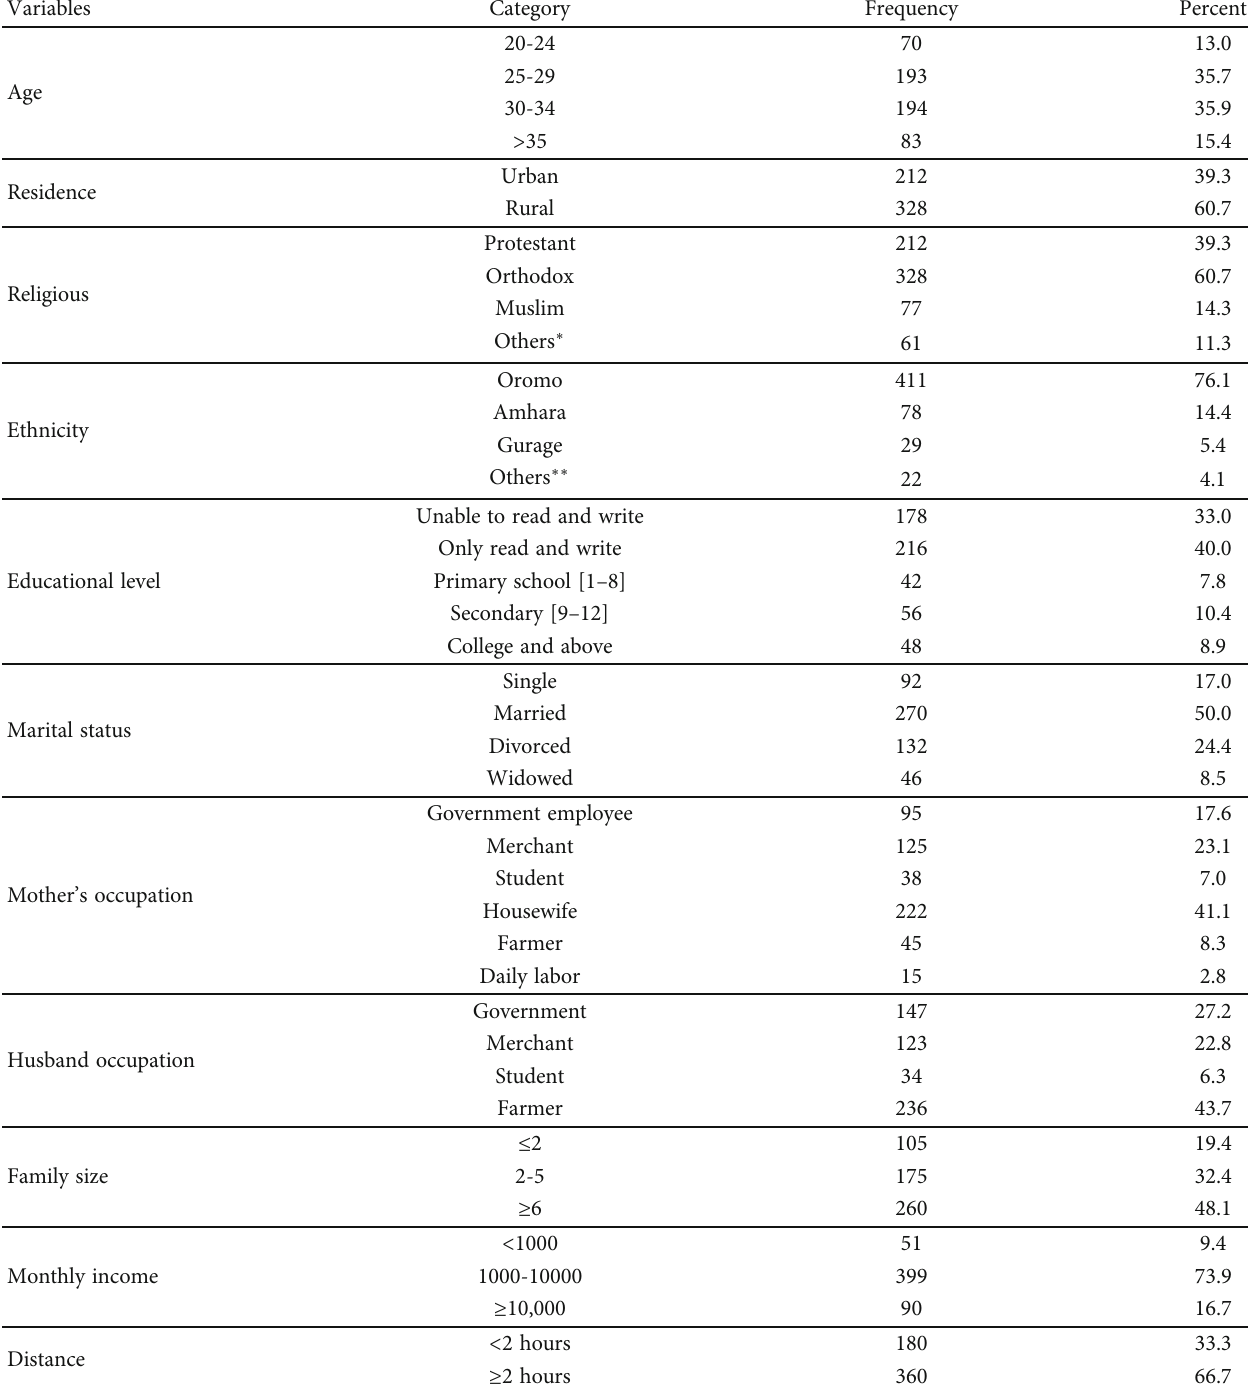
Table 1: Sociodemographic characteristics of respondents among pregnant women living Ilu Gelan district, West Shewa Zone, Ethiopia 2021 ( n = 540